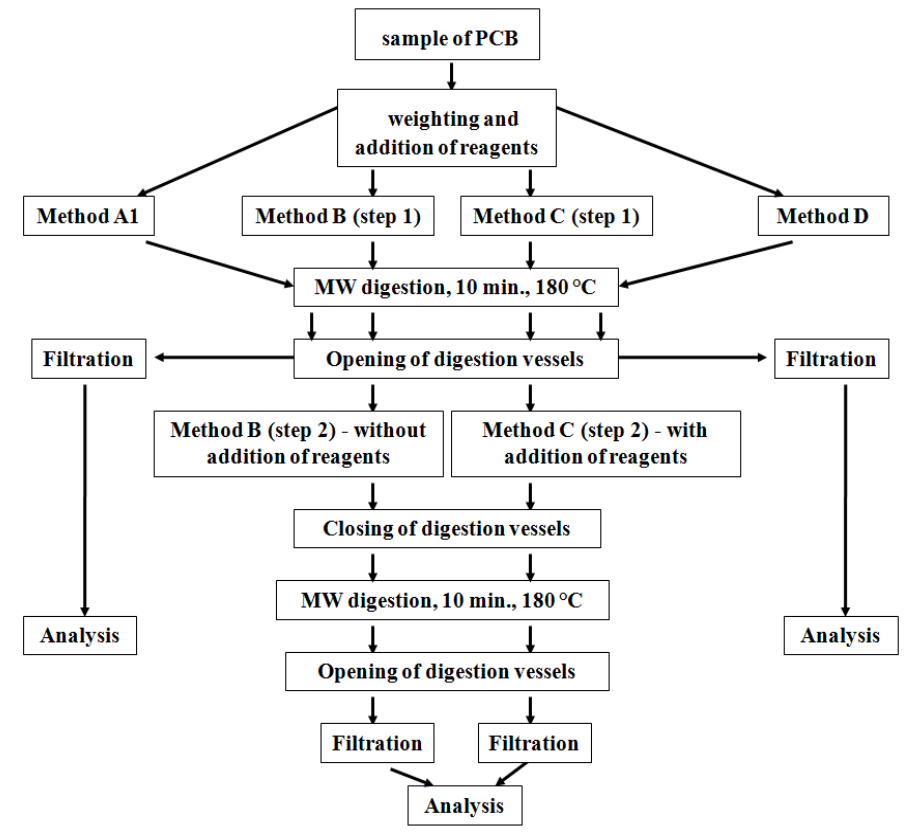
Figure 2. Block diagram of microwave (MW) digestion procedural steps.